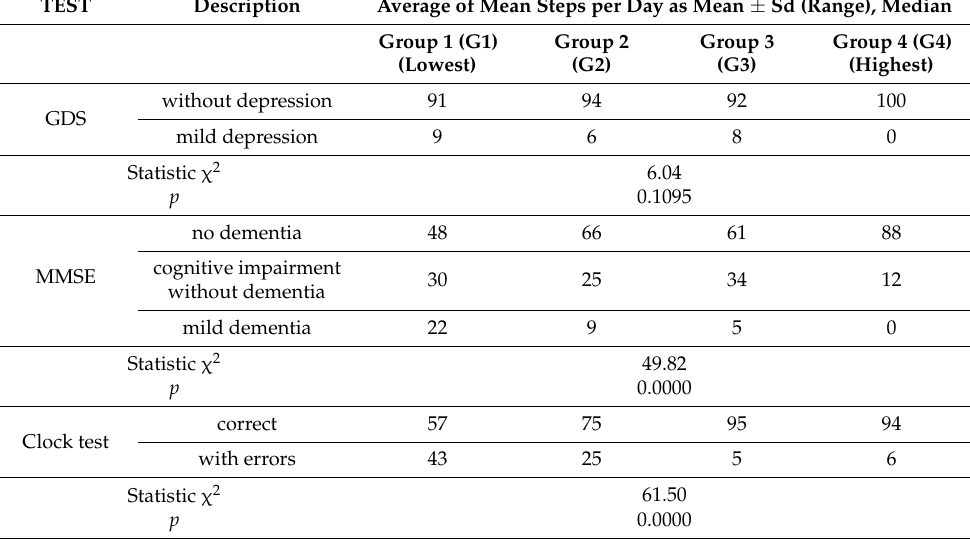
Table 3. The percentage distribution and statistics of the results of the depression and dementia tests performed among the studied